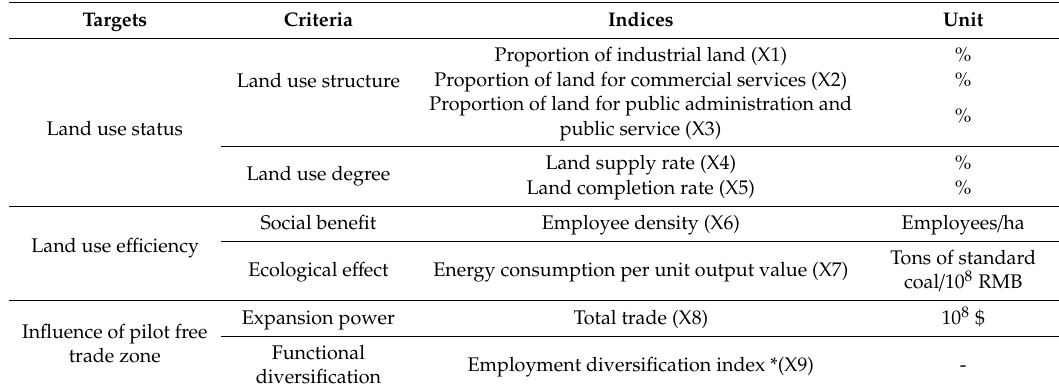
Table 2. Evaluation index system of intensive land use in the SPFTZ.